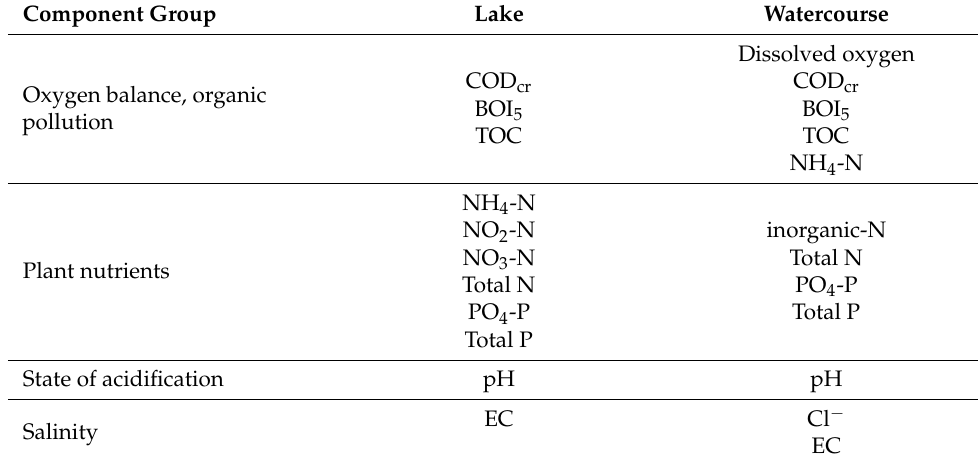
Table 1. Component groups for lakes and water courses.